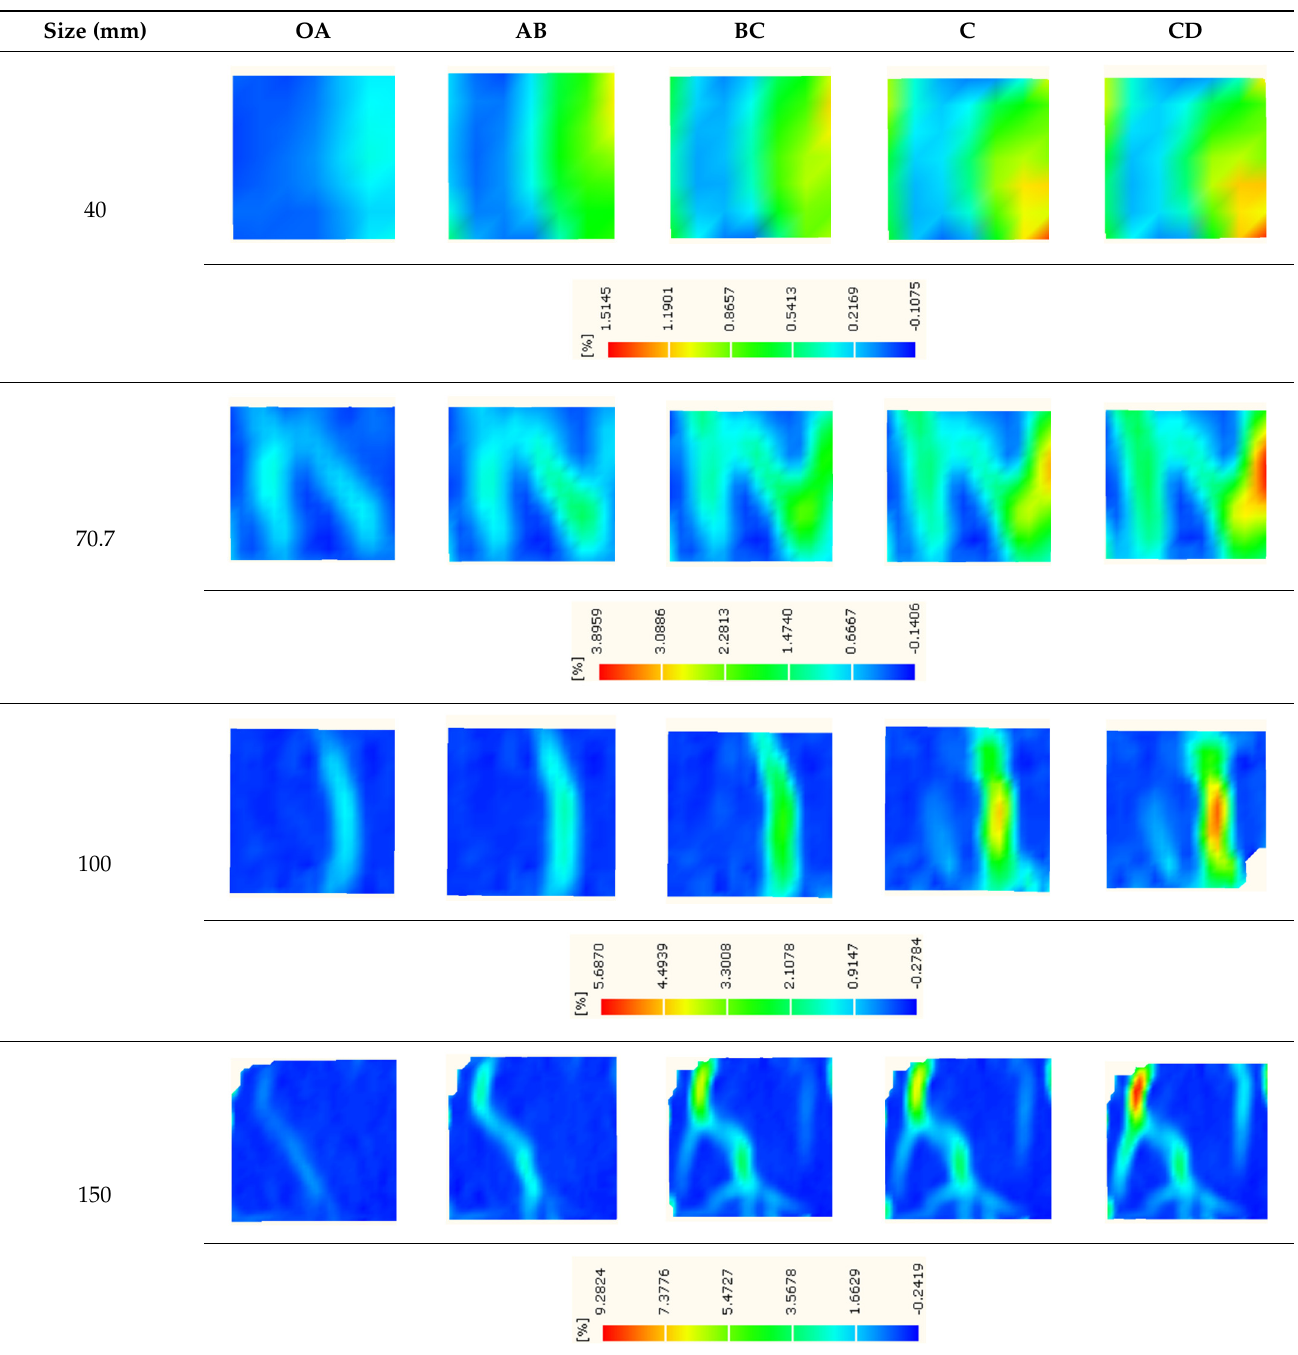
Table 2. Nephogram of strain field evolution of backfills with different sizes.